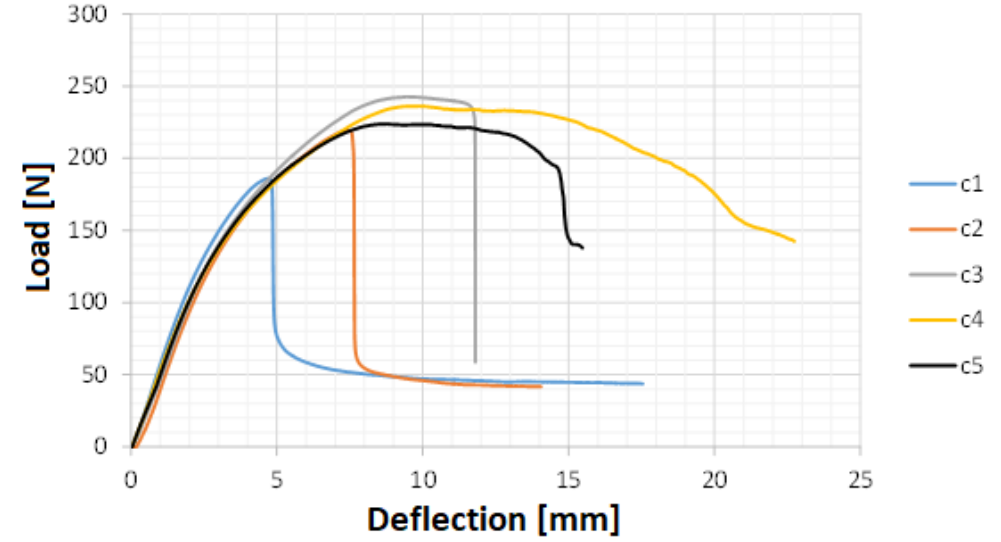
Figure 13. Load vs. mid-span deflection of sandwich panel 1.